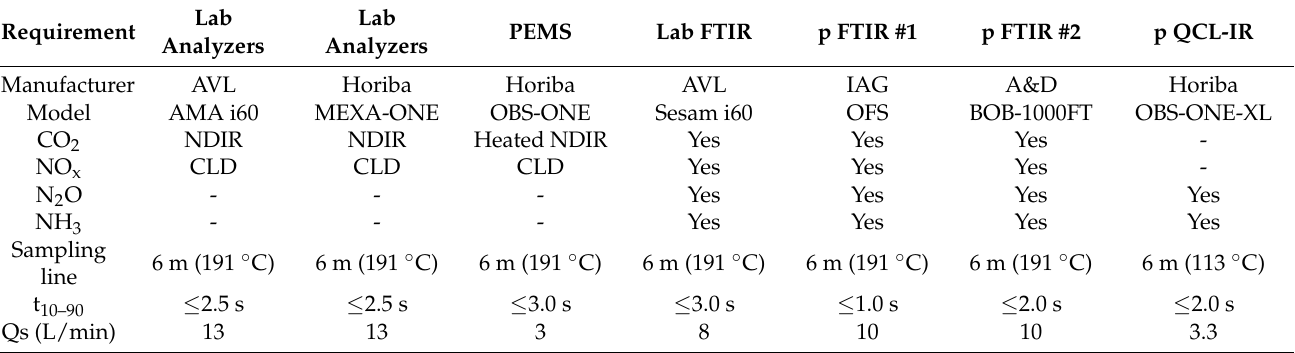
Table 2. Technical specifications of the instruments. The only principle that needs removal of water from the exhaust gas (dry measurement) is NDIR. Heated NDIR, CLD, FTIR, and QCL-IR measure “wet”